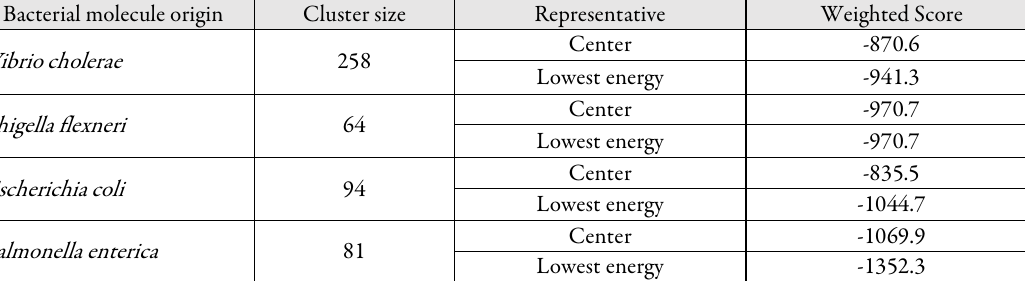
Table 4. Model scores for the docking coagulation factor II to bacteria species. with the energy of the cluster center (i.e., the structure that has the highest number of neighbours structures in the cluster), and the